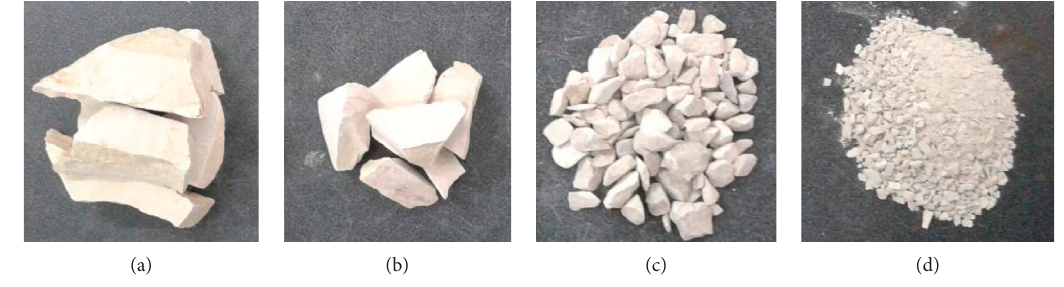
Figure 2: Steps of the crushing process of the marble waste. Table 3: Chemical composition of crushed waste marble.